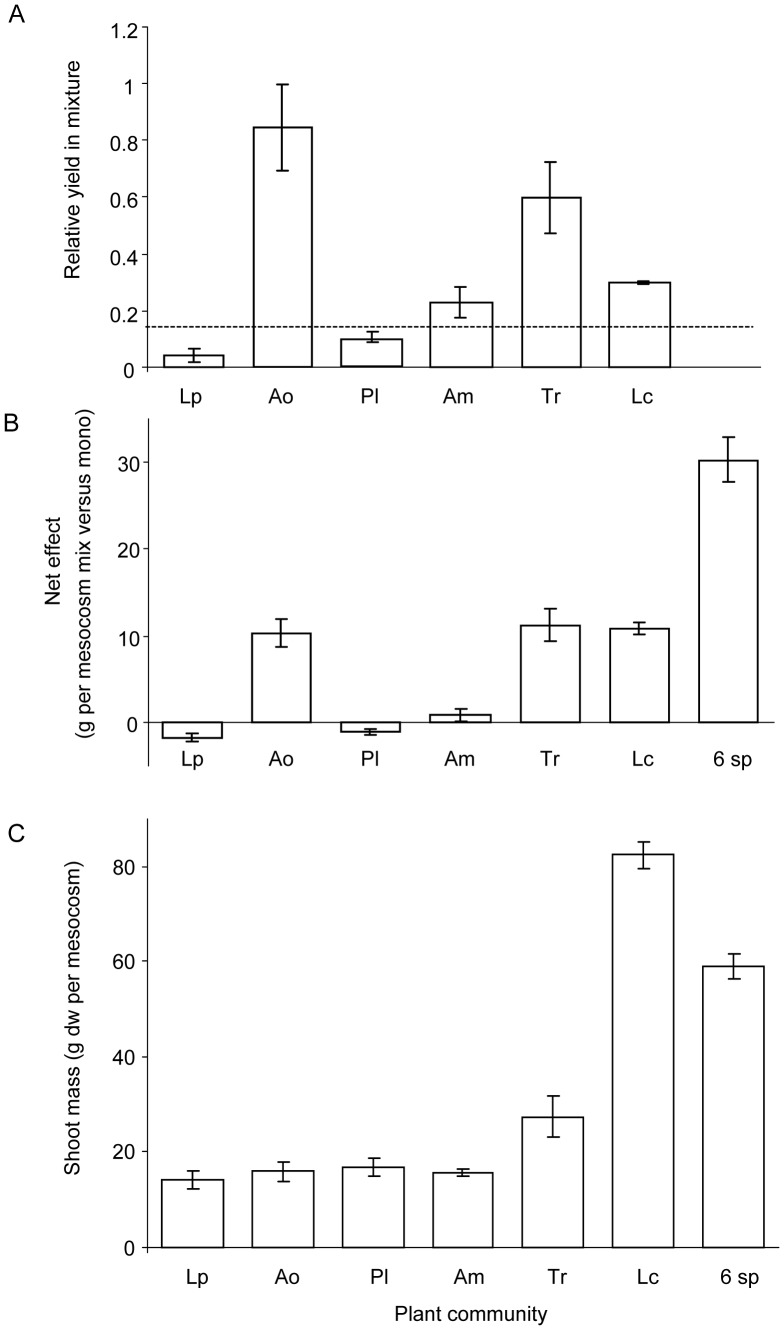
Plant species specific performance in species mixture and total biomass of monocultures and species mixtures.
Relative yield (A), net effect (B) and average shoot biomass (C) per mesocosm (38 × 38 cm) of each of the six species grown in monoculture and 6-species mixtures. Bars are means ±1 SE (N = 4); the horizontal dotted line in panel A indicates 1/6th of the yield. Species names are Tr = Trifolium repens, Lc = Lotus corniculatus, Pl = Plantago lanceolata, Ao = Anthoxanthum odoratum, Am = Achillea millefolium, Lp = Lolium perenne.